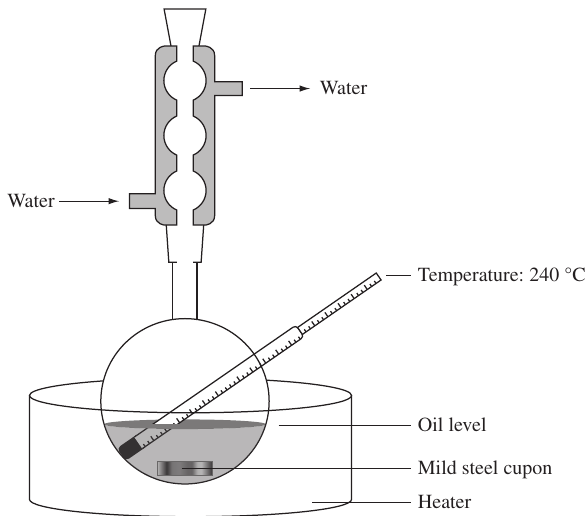
Figure 1. Corrosion test system.